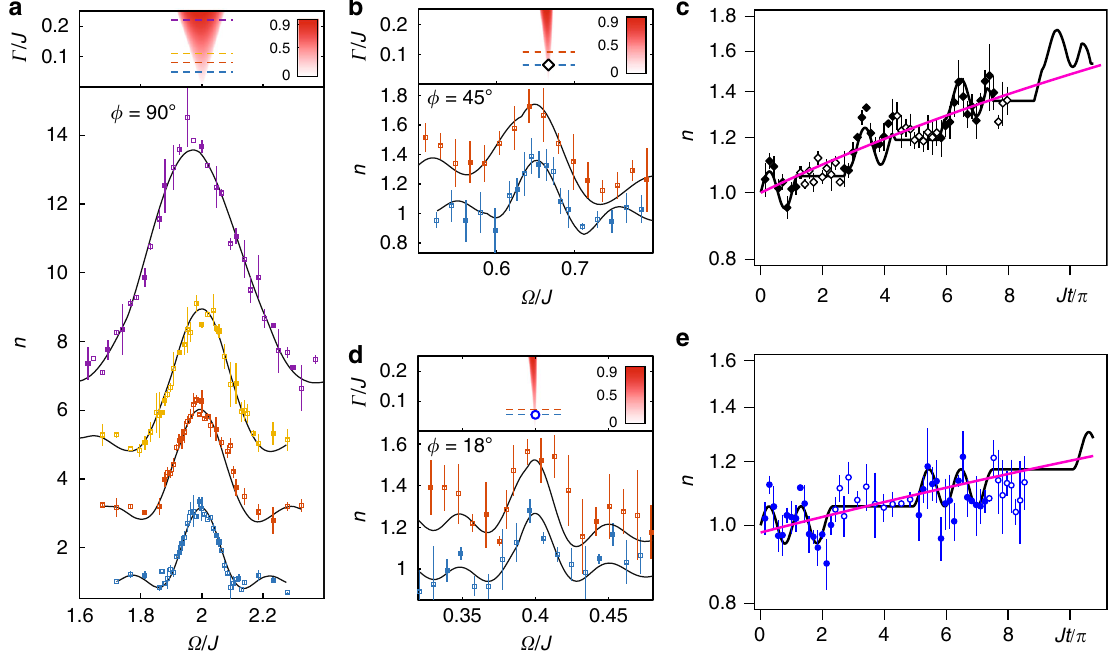
Fig. 2 Detecting the resonances with time-periodic dissipation. a n ( t f , Ω ) around the one-photon resonance Ω n = 2 J . Purple for Γ / J = 0.22, t f = 1.98 ms; Yellow for Γ / J = 0.11, t f = 3.31 ms; Red for Γ / J = 0.082, t f = 3.97 ms; and Blue for Γ / J = 0.05, t f = 5.29 ms. b n ( t f , Ω ) around the three-photon resonance Ω = 2 J /3. Red for Γ / J = 0.11, t = 2.80 ms; Blue for Γ / J = 0.065, t = 3.79 ms. c n ( t ) at Ω = 2 J /3 with Γ / J = 0.065 located in ( b ) by the diamond shape. n f f n d n ( t f , Ω ) around the fi ve-photon resonance Ω n = 2 J /5. Red for Γ / J = 0.07, t f = 4.64 ms; Blue for Γ / J = 0.055, t f = 4.74 ms. e n ( t ) at Ω n = 2 J /5 with Γ / J = 0.055 located in ( d ) by the circle shape. The initial phase ϕ of the square-wave modulation is chosen to anti-synchronize to the RF fi eld with ϕ = π /2, π /4, π /10 for one-, three-, and fi ve-photon resonance respectively. In a , b , and d , all the data and simulation curves have a base line of n = 1, but are vertically shifted for the presentation purpose. The side peaks are due to the fi nite probe time. In c , e , the data with solid shapes corresponds with the dissipation on, the data with empty shapes are with the dissipation off, and the pink curves are the exponential fi tting. For all fi gures, the solid curves are numerical simulations without free parameter. The error bars represents the standard deviation of the